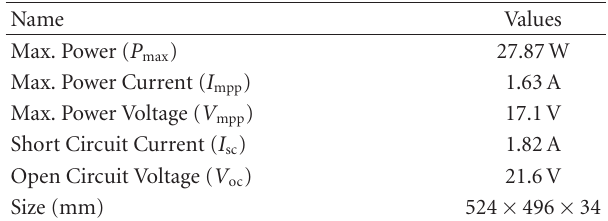
of line segments, that is, a piecewise linear approximation.